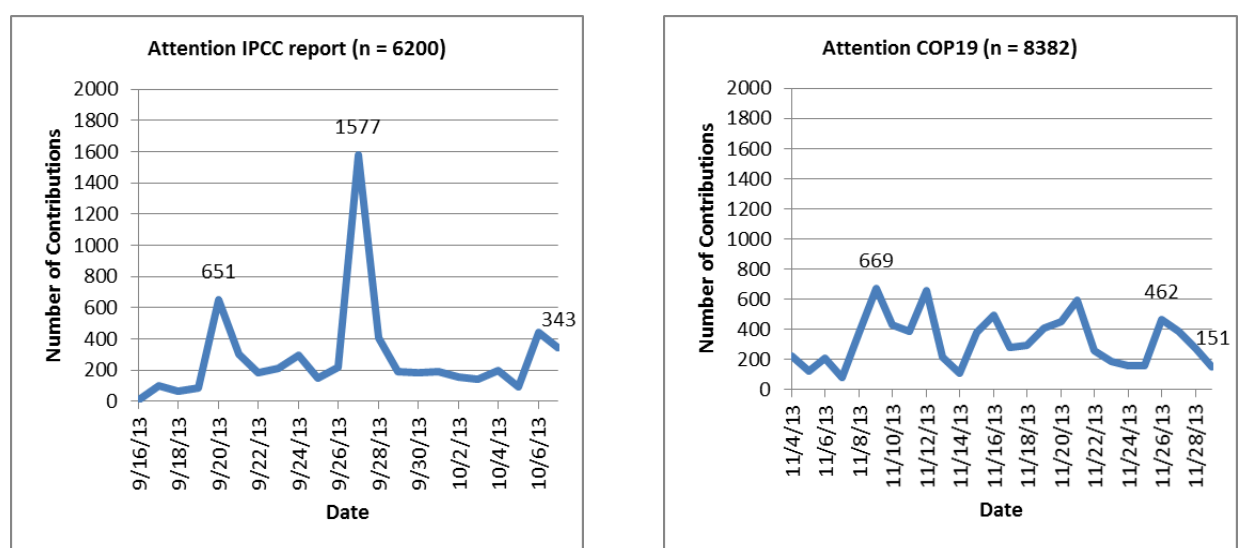
Figure 1. Dynamics of attention during the release of the IPCC report 2013.